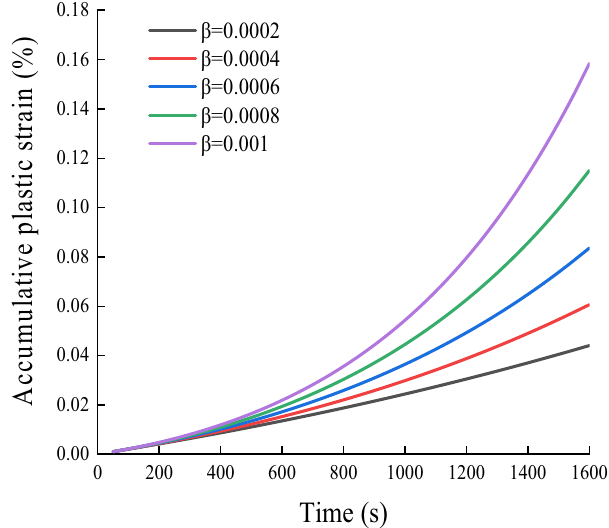
Figure 10. Development curve of cumulative plastic strain of nonlinear viscoplastic model considering damage.